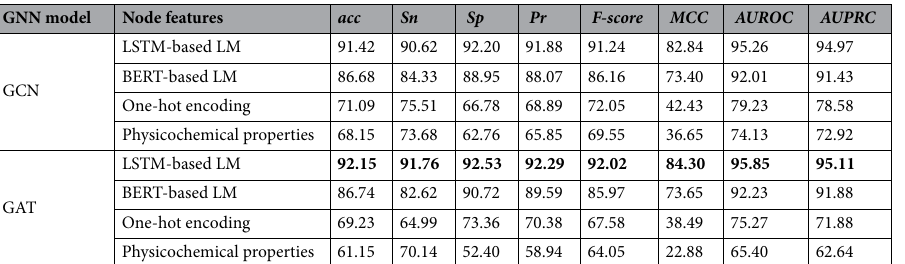
Table 4. Performance of GNN variants using different node features on S. cerevisiae test set. Best values are in bold.